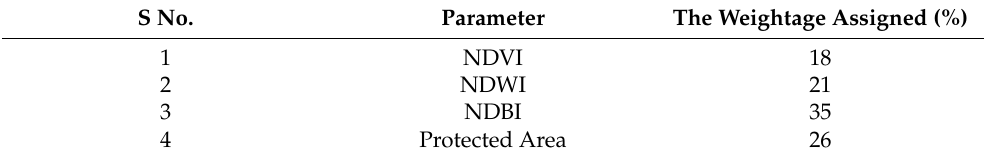
Table 1. Details of Weightage assigned to the Indices. S No. Parameter The Weightage Assigned